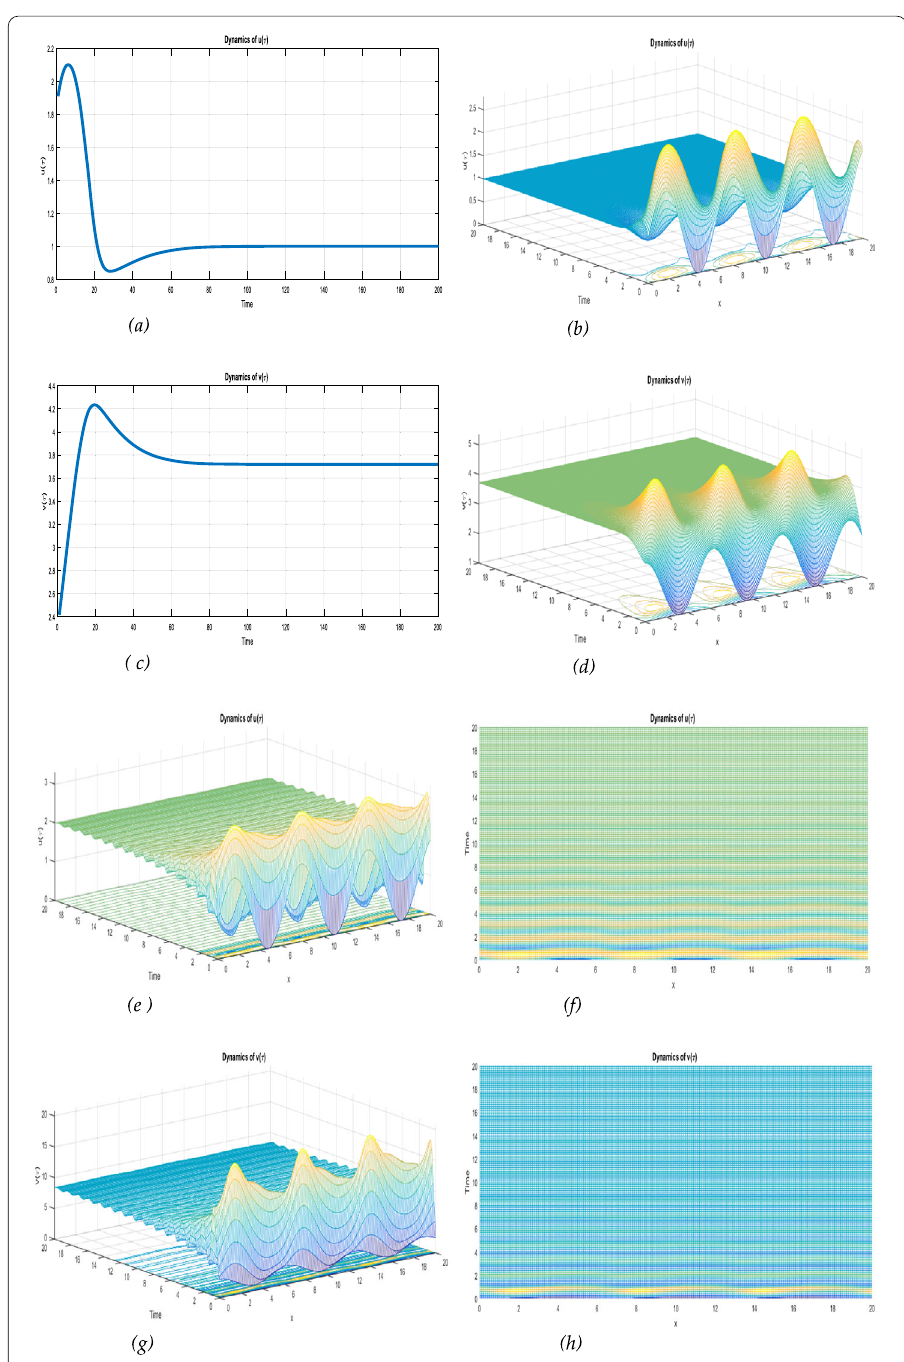
Figure 5 ( a )–( d ) Numerical solutions of system (49) using Crank–Nicolson scheme. Here, u 0 = 1 + sin( x ) and v 0 = 2 + cos( x ), with l = 5, m = 1, κ 1 = 0.01, and κ 2 = 0.01. (Top) The concentration of u ( τ ) is on the left while the concentration of v ( τ ) is on the right. (Bottom) The solutions v ( x , τ ) and u ( x , τ ) tend to the constant steady state. ( e )–( h ) Numerical solutions of system (49) using Crank–Nicolson scheme. Here, u 0 = 1 + sin( x ) and v 0 = 2 + cos( x ), with l = 10, m = 20, κ 1 = 0.01, and κ 2 = 0.01. (Top) The solutions v ( x , τ ) and u ( x , τ ) tend to the spatially nonhomogeneous steady states. (Bottom) The projected views onto the x τ -plane at τ = 20 for v ( x , τ ) and u ( x , τ ). The stripe structure invades the nonhomogeneous steady states for v ( x , τ ) and u ( x , τ